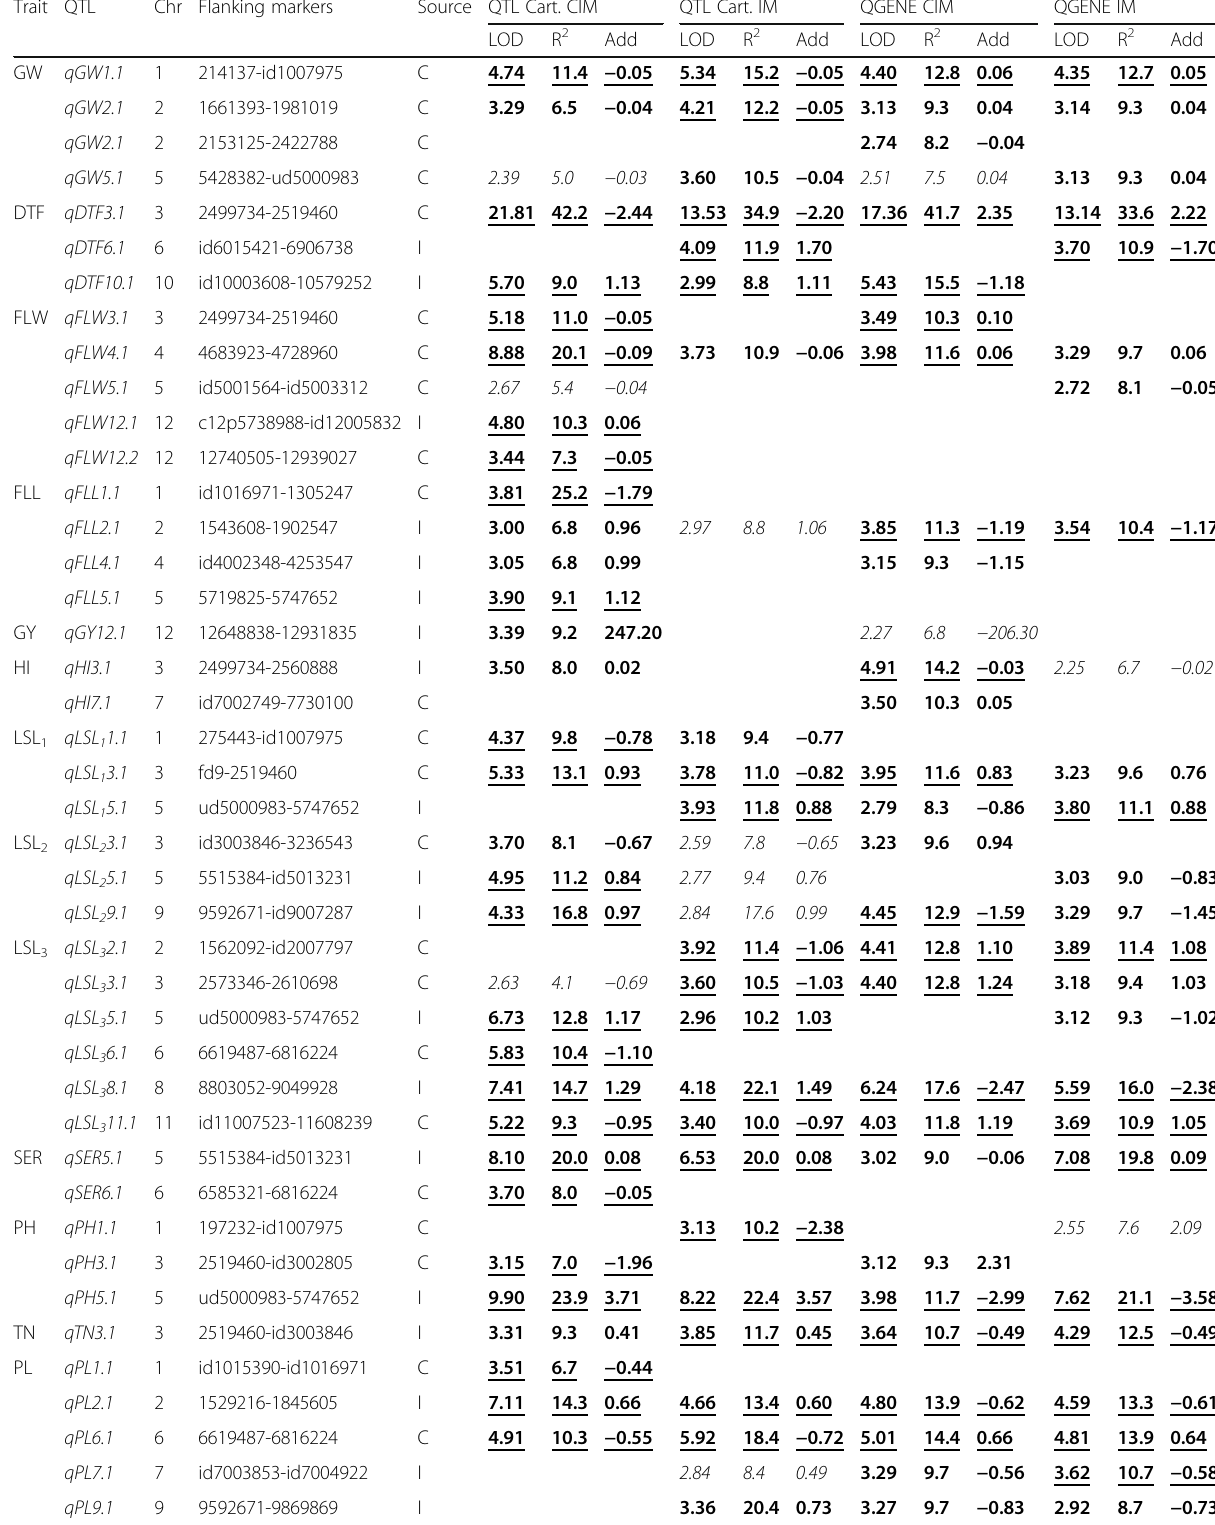
Table 4 QTLs for yield in agronomic traits from a RIL population of Ciherang-Sub1/IR10F365 identified under irrigated control condition Trait